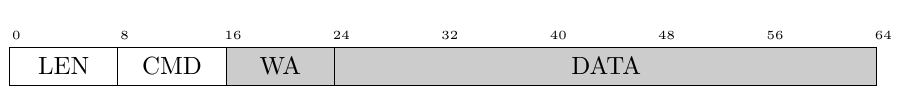
Figure 1: The SPI frame structure. All frames sent to the DST chip include a length (LEN) and command (CMD) field. Some of these frames additionally require write access (WA) and/or data fields. For a specific set of commands, the DST chip will reply with a few data bytes (e.g. in the case of an EEPROM read or response request). microcontroller can interact with the TMS37126 using SPI [MWC12]. For example, it illustrates the SPI frame structure and shows how to interact with the chip to execute